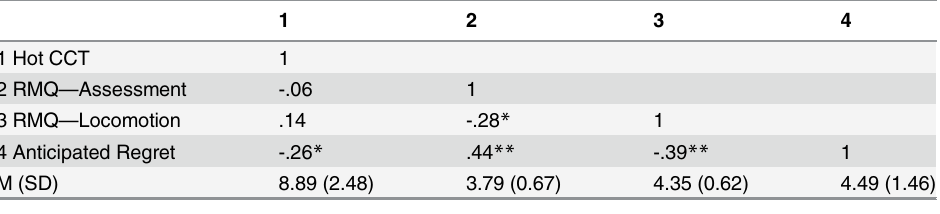
Table 2. Means, Standard Deviations and Intercorrelations between Independent Variables, Mediator and Risk-Taking.